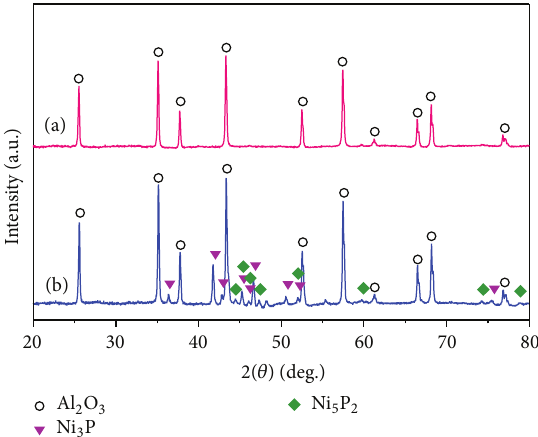
Figure 4: XRD profiles of the (a) as-received Al 2 O 3 -10wt.% Ni- P powders and (b) Al 2 O 3 -10wt.% Ni-P powders calcined at 450 ∘ C after electroless Ni-P coating